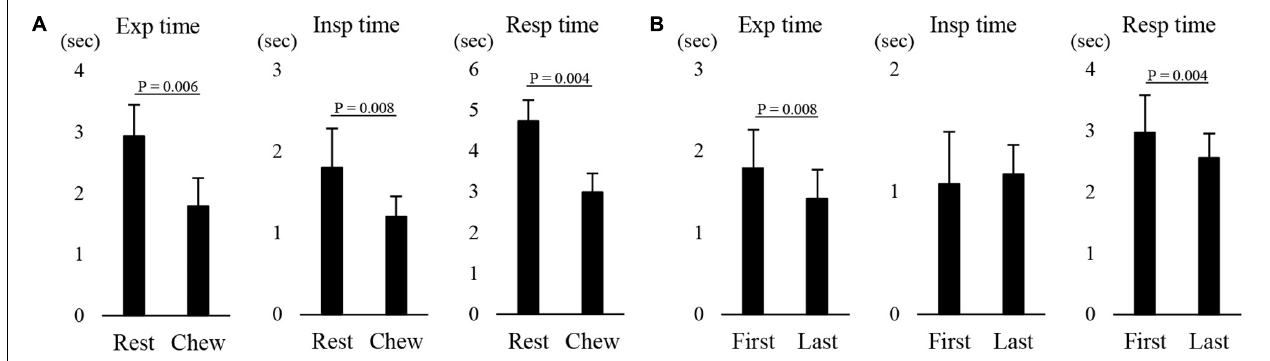
FIGURE 10 | Effect of chewing on respiratory movements. (A) There were significant differences in the expiratory (Exp time), inspiratory (Insp time), and respiratory time (Resp time) between at rest (Rest) and during chewing (Chew) (paired t -test). (B) There was a significant difference in the Exp time and Resp time between the first and last respiratory cycles (paired t